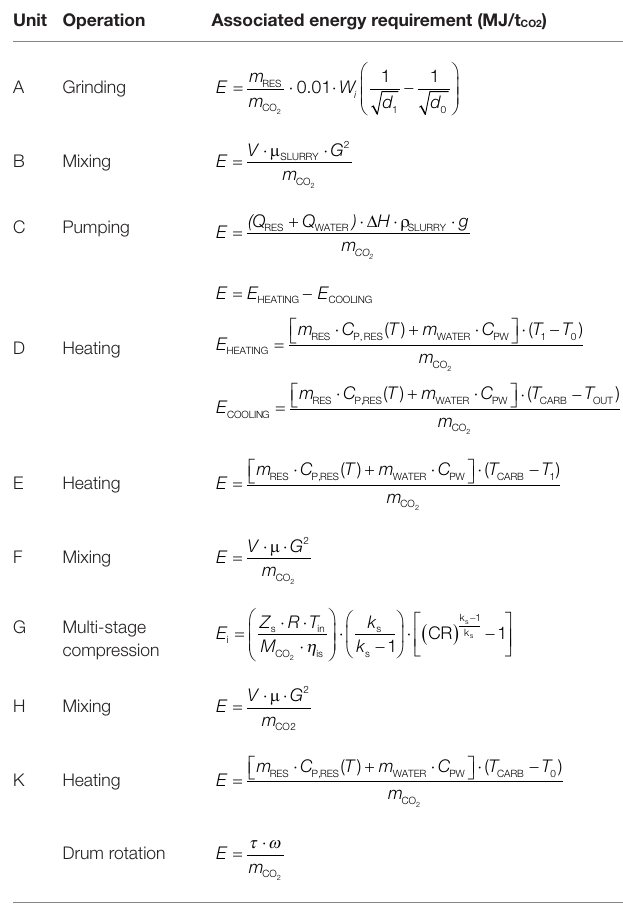
TaBle 3 | equations used to assess the energy requirement associated to each unit considered for the two carbonation routes. Unit